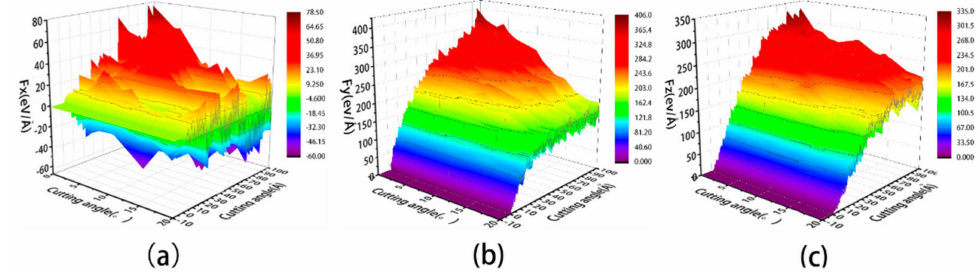
Figure 6. Variation of cutting force with cutting distance. ( a ) Fx; ( b ) Fy; and ( c )